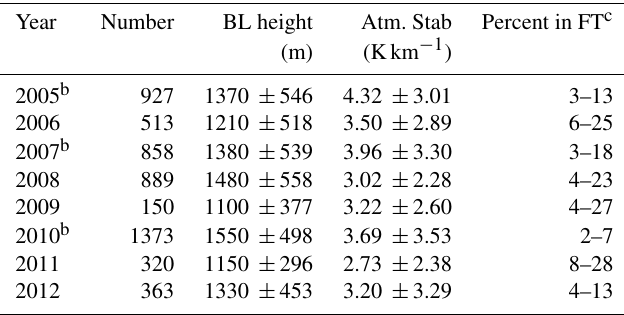
Table 3. Summary of the main atmospheric parameters calculated at the location of the plumes per year a